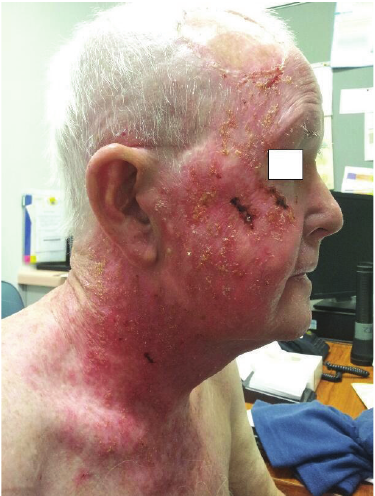
Figure 1: Clinical photograph in week two of radiotherapy showing extensive in-field erythema, areas of dry and confluent wet desqua- mation, papulopustular changes, and focal regions of haemorrhage.